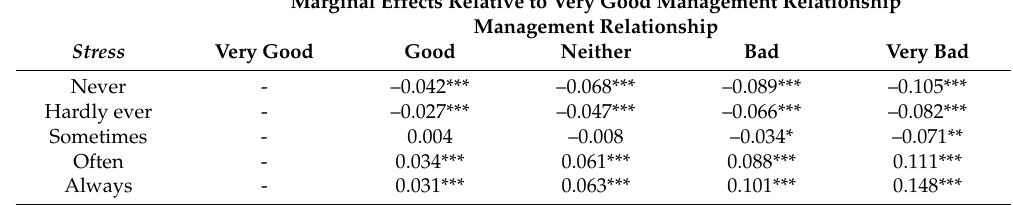
Table A5. Estimated marginal effect of relationship between management/staff on work-related stress—females.